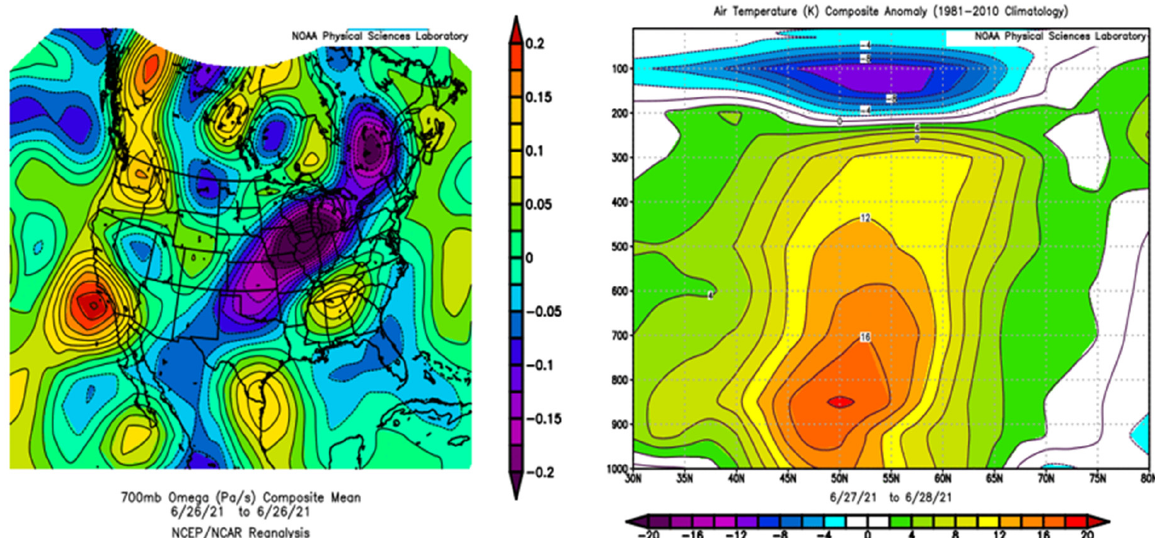
Figure 5. ( left ) Subsidence estimates (Pa/s) during 26 June 2021 for the North American west coast based on the Omega equation [5]. Positive values are downward motions. ( right ) Anomalies of air temperature on a south-north vertical cross-section along 122° W longitude. Maximum values of 16 °C were above the surface in the lower troposphere. Images from NOAA/ESRL plotting routines based on the NCEP/NCAR reanalysis.